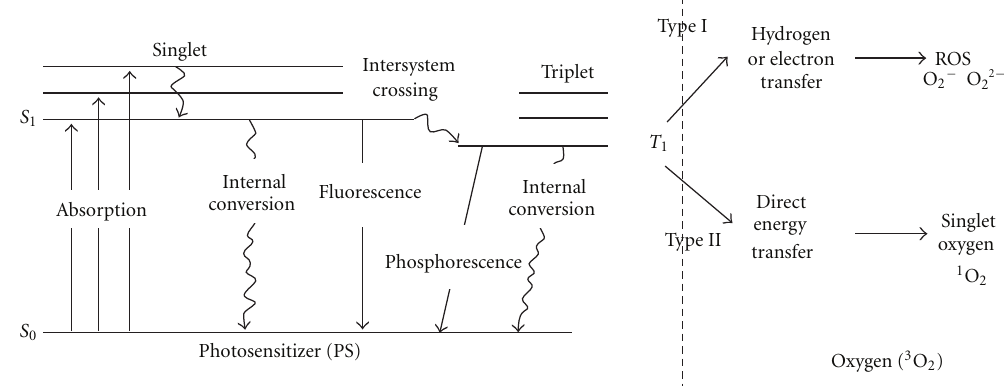
Figure 1: Jablonski diagram showing energy transfer from photosensitizers (PSs) to molecular oxygen [4].